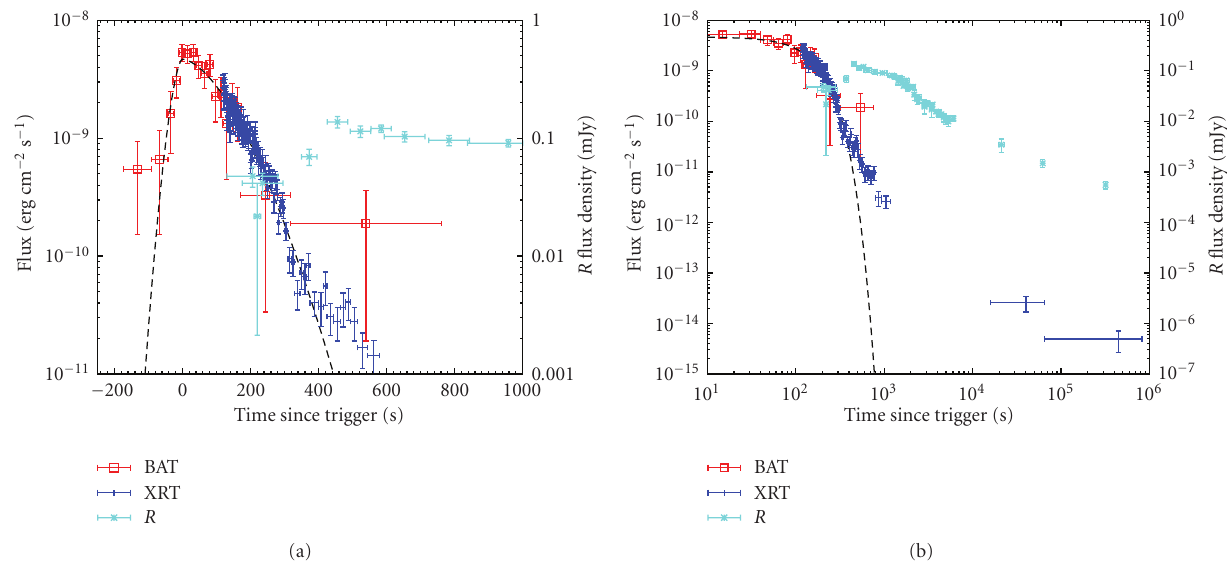
Figure 5: γ -ray, X-ray, and optical light curves of GRB 070419A. (a) Early-time light curves plotted on linear-log scale. (b) Later time evolution included and shown on log-log scale (see Melandri et al.